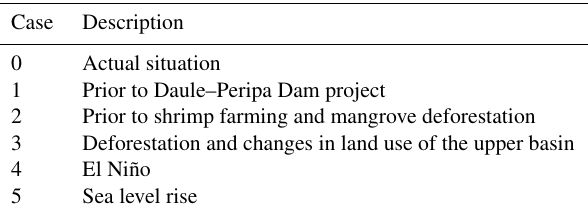
Table 2. List of cases simulated as part of this